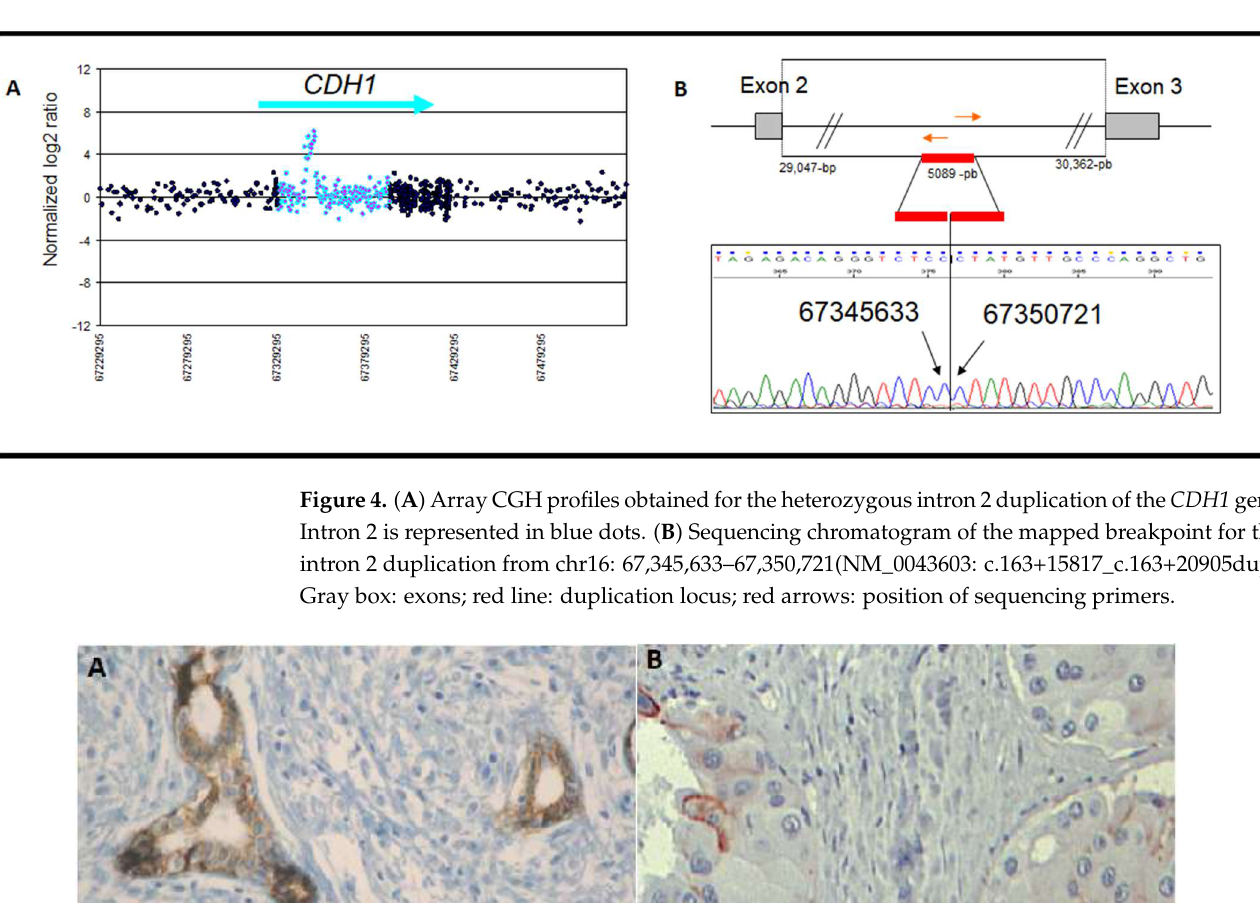
Figure 4. ( A ) Array CGH profiles obtained for the heterozygous intron 2 duplication of the CDH1 gene. Intron 2 is represented in blue dots. ( B ) Sequencing chromatogram of the mapped breakpoint for